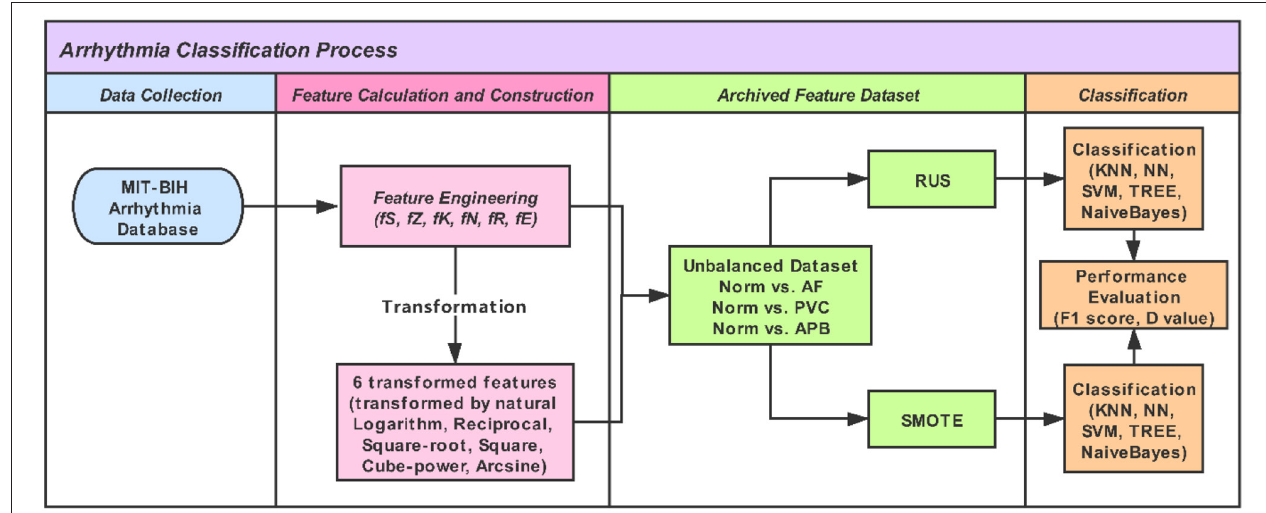
FIGURE 1 | A work flowchart of this